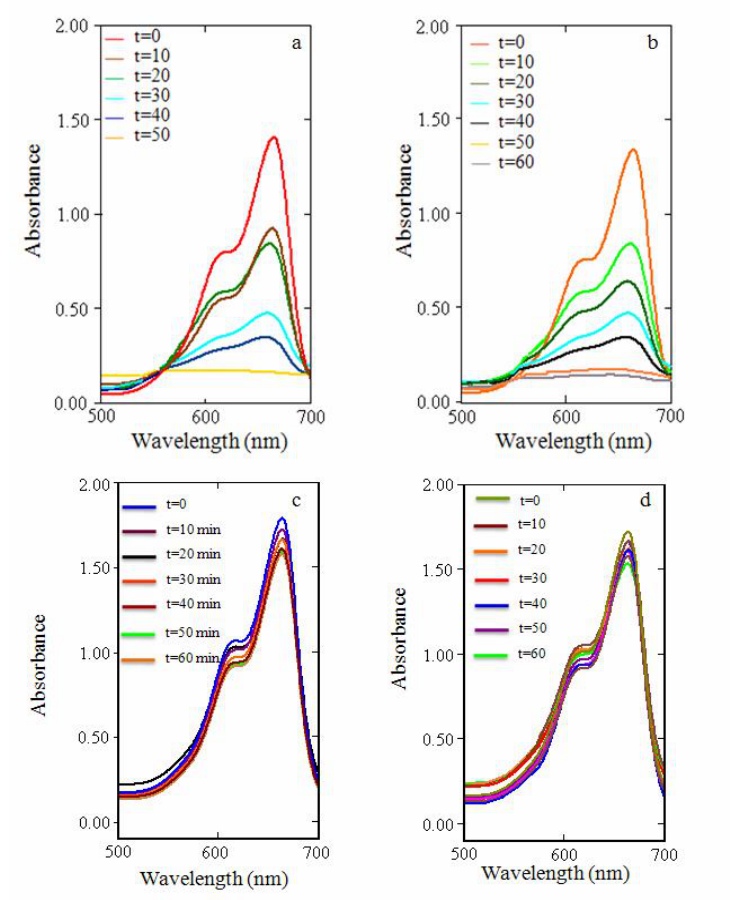
Fig. 6. Changes of UV-Vis spectra during the degradation of MB on a) TiO solar light irradiation; c) TiO ; d) ZnO in the absence of solar light irradiation. 50 mg 2 catalyst; 50 ml MB (10 mgl -1